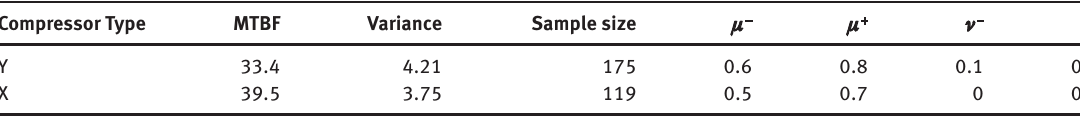
Table 1: IVIF Data Regarding Two Types of Radiators (Infinite Populations).